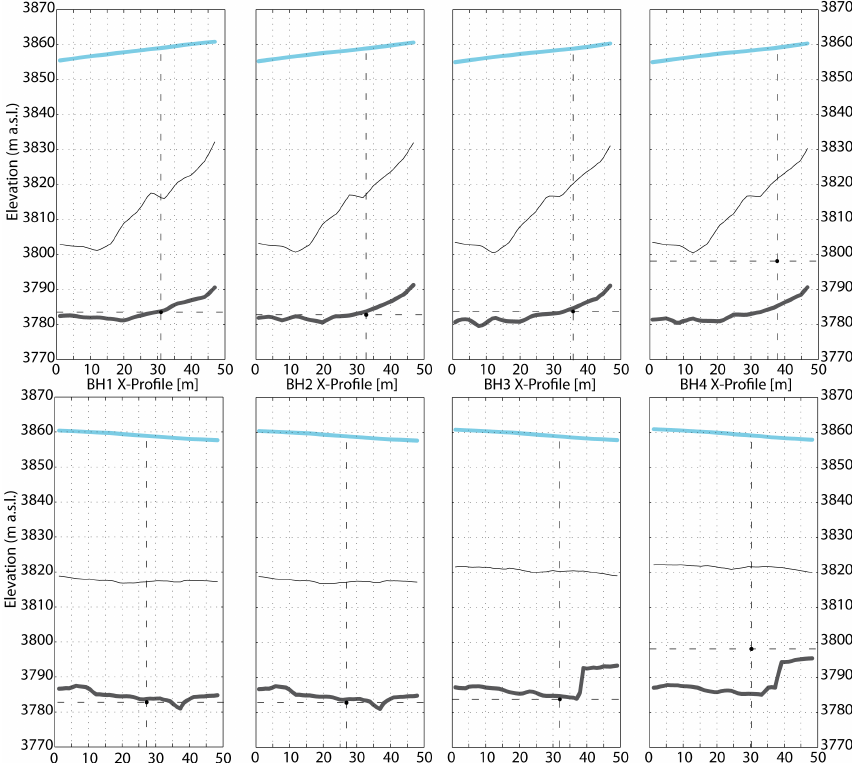
Figure 5. The top images illustrate the GPR X -profiles (constant y coordinate) and Y -profiles (constant x coordinate) through the locations of boreholes no. 1–4 (see also Fig. 6). Two-dimensional slices of the interpolated bedrock surfaces (thick grey line) and a possible englacial layer (thin grey line) are shown. The thick blue line indicates the glacier surface. Black dots show the logged depths for boreholes no.